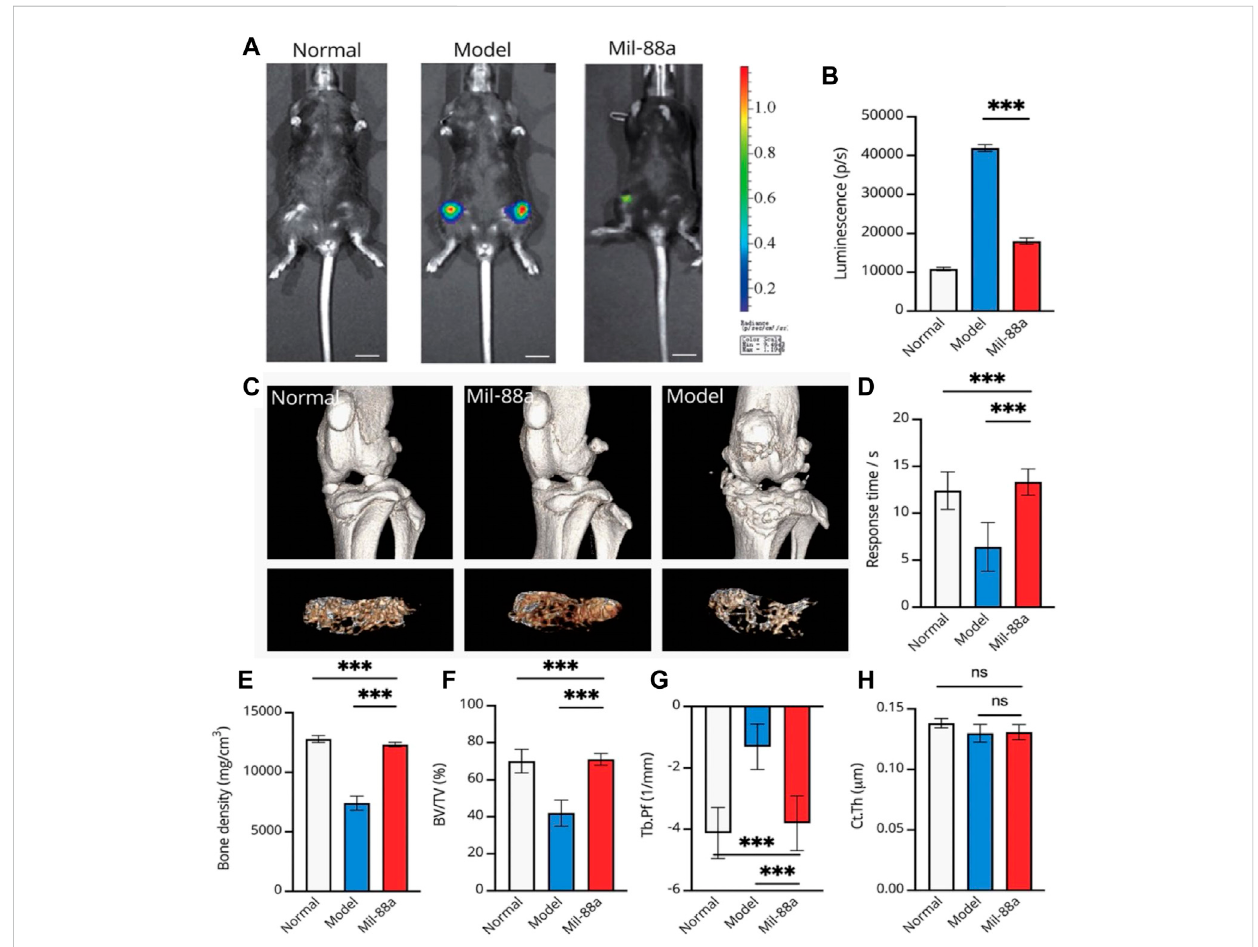
FIGURE 4 Representative luminescence imaging in vivo and evaluation of bone density in the mouse joint using micro-CT. Evaluation of osteoarthritis using luminescence imaging (A, B) . The 3D reconstruction of CT indicates the bone changes, and the tibial plateau section shows the structure of bone trabeculae (C) . For evaluating the response time, mice were placed on the heating platform at 55 ° C, and the reaction time of licking and jumping was shown; amicro-CT scanof thejoints ofmice wasperformed (C, D) . Bone density (mg/cm 3 ) (E) , bone volume fraction (BV/TV) (F) , trabecular pattern factor (Tb.Pf, 1/mm) (G) , and cortical bone thickness (H) were used to assess subchondral bone changes in osteoarthritis by quantitative CT. Values were presented as mean ± SD. ppp p < 0.001 ( n =